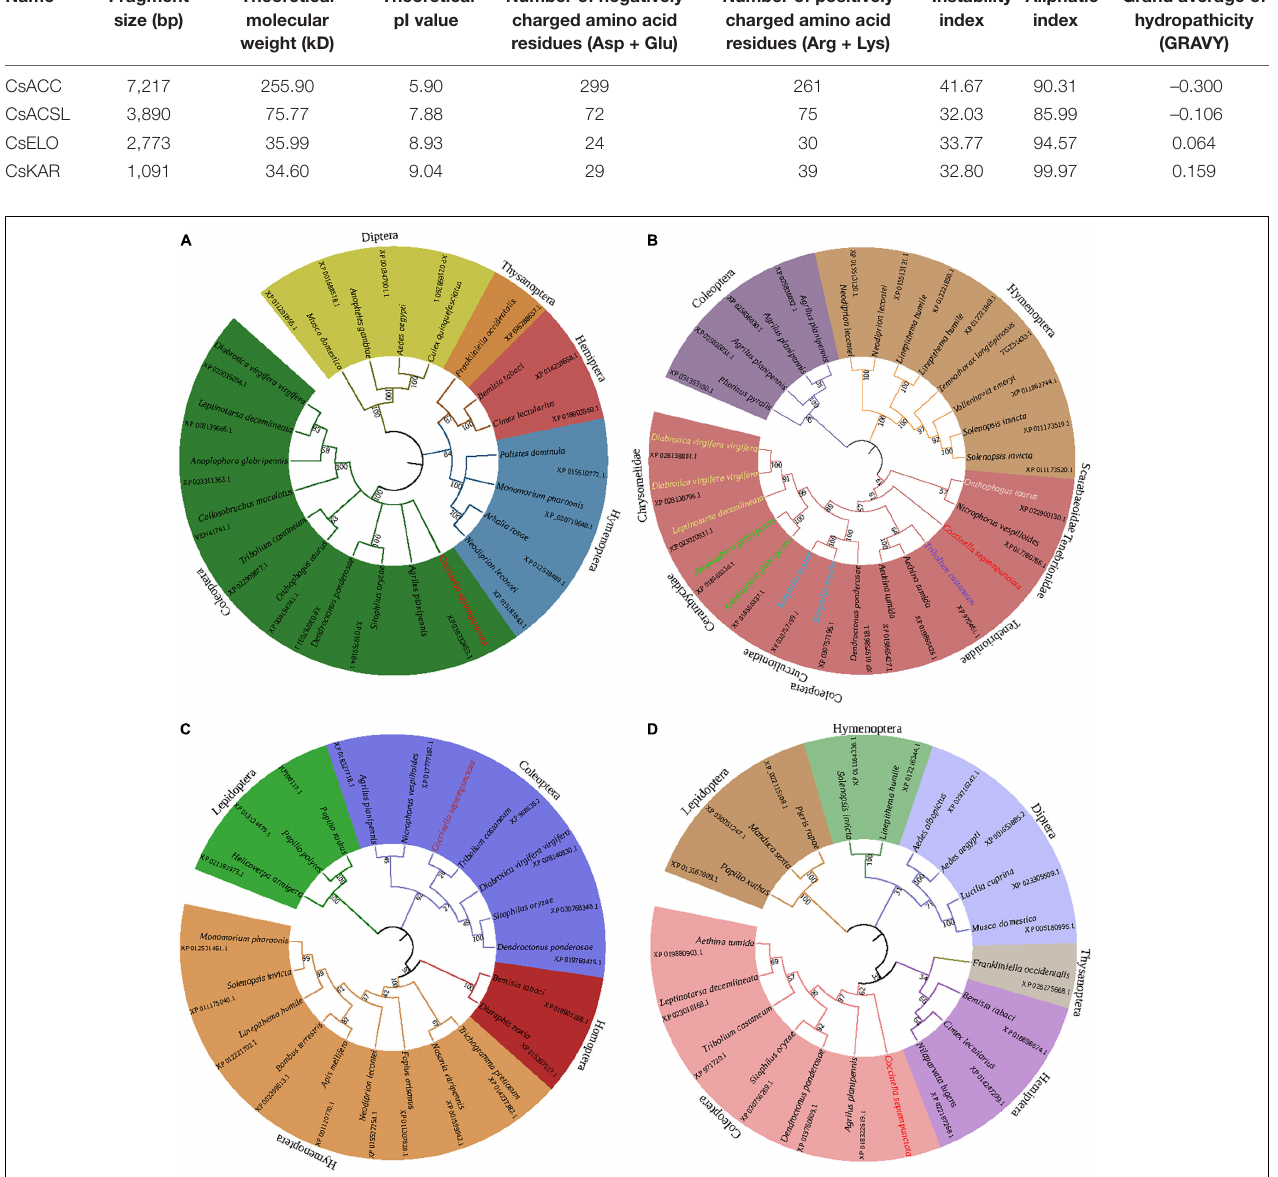
FIGURE 1 | Phylogenetic trees of CsACC (A) , CsACSL (B) , CsELO (C) , and CsKAR (D) . The phylogenetic trees were constructed by the neighbor-joining method and supported by bootstrap analysis with 1,000 replications. The numbers above the branches represent the bootstrap